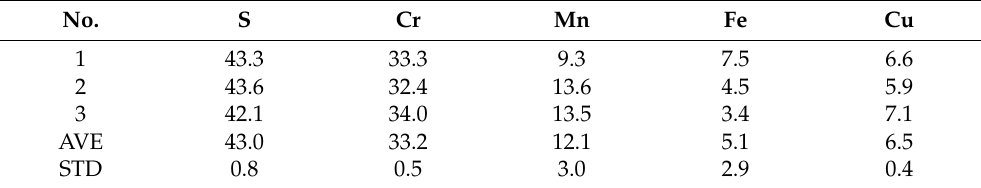
Figure 9. Precipitation in δ -ferrite; ( a ) precipitation of sulfide particles along the subgrain boundaries in δ -ferrite, needle-shaped cementite particles. SE image; ( b ) precipitation of sulfides in δ -ferrite, zone axis [114] Cr2CuS4 , extraction carbon replica. TEM. Table 2. Results of semi-quantitative EDX analyses of fine sulfides (at. %).